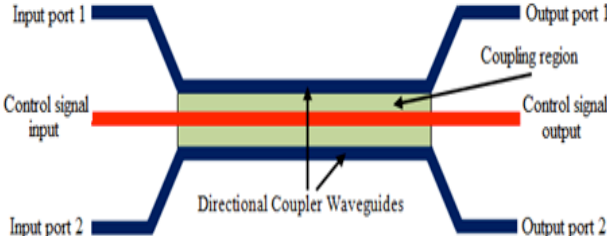
Figure 1: Schematic diagram of the all-optical switch based on a directional coupler.